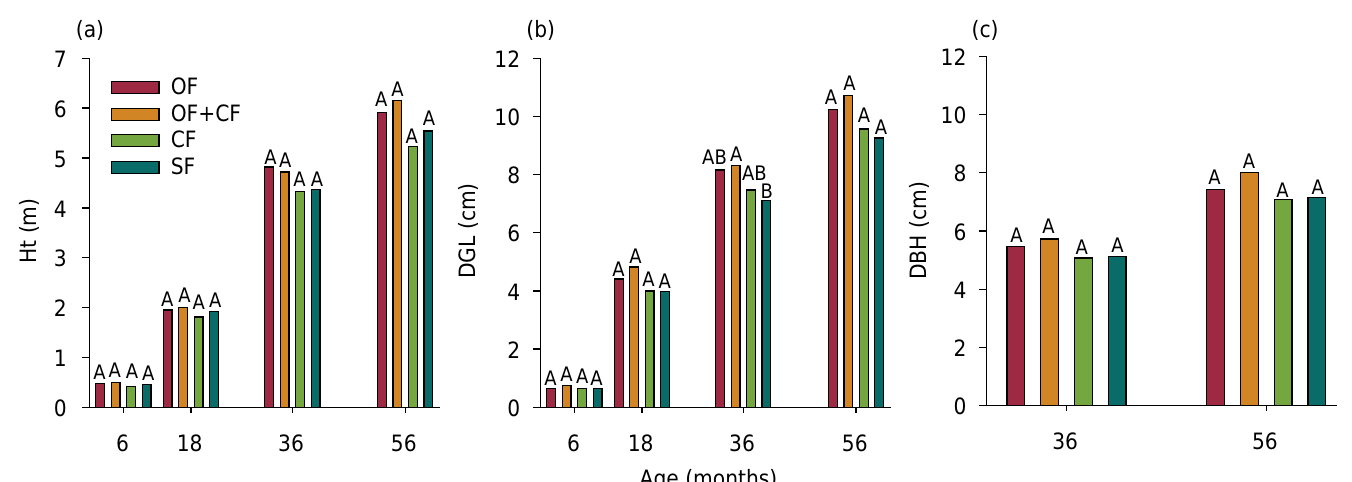
Figure 1. Growth in height, Ht (a); trunk diameter at ground level (DGL; b), trunk diameter at breast height (DBH; c) in A. peregrine at 6, 18, 36, and 56 months of age, submitted to organic (OF), combined organic and chemical (OF+CF), chemical (CF), and standard (SF) fertilizers, planted in an area of bauxite mining . Uppercase letters compare fertilization treatments within the same age and, when equal, indicate no differences between them by the Tukey’s test at 10 % probability